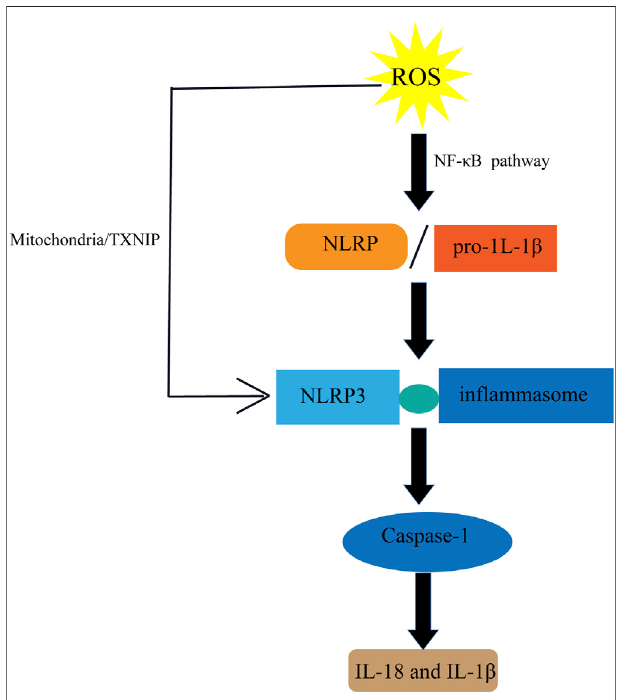
FIGURE 9 | Antioxidants and ROS. Antioxidant function of vitamins C, E and melatonin.